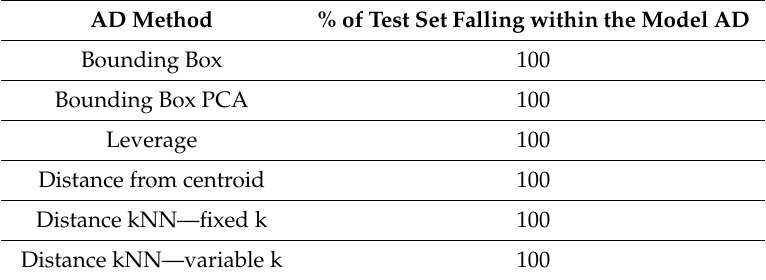
Table 4. Percentage of test set instances falling within the model AD according to di ff erent AD